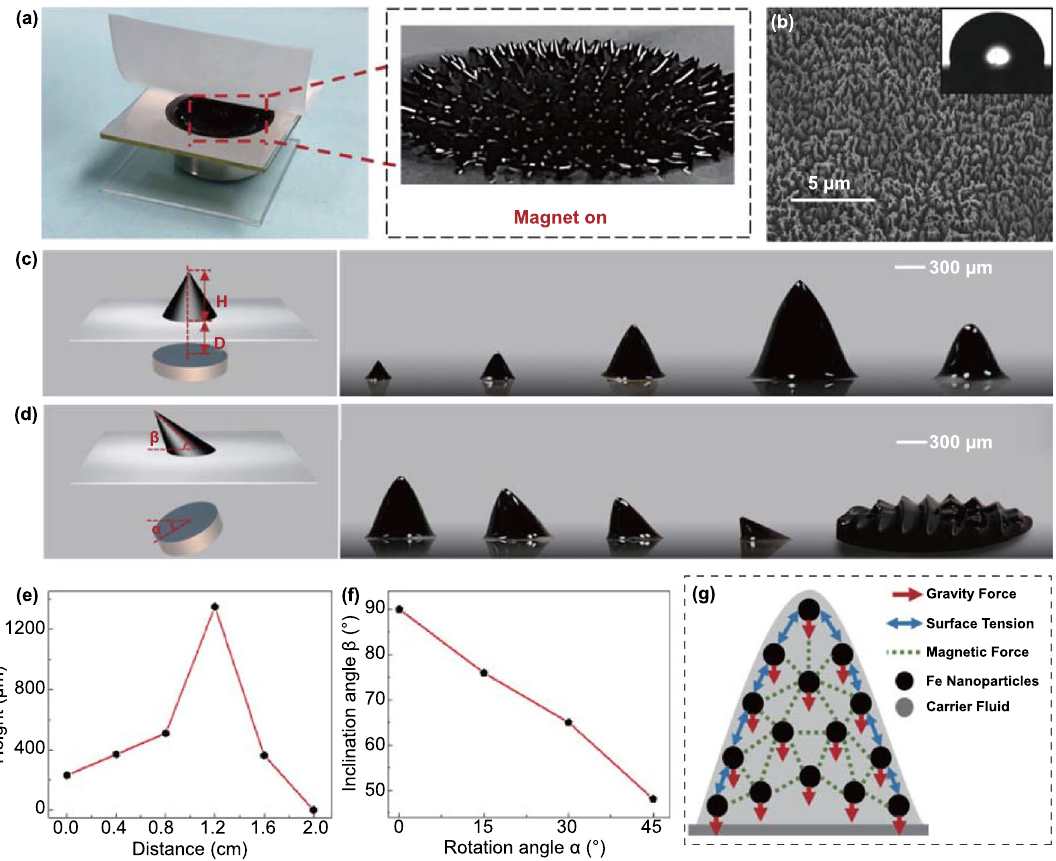
Fig. 1 Dynamic behaviors of the ferrofluid. a Photograph of FTTS. Inset displays the topography of microstructure in response to magnetic field. b The SEM image of PTFE membrane used to contact with ferrofluid, scale bar 5 μm. Inset shows the photograph of its contact angle. Schematic illustration and real-time microscope images of the dynamic behaviors of the ferrofluid in response to changing c distance and d angle with the magnet, scale bar 300 μm. Quantitative relations between different magnet conditions and geometric parameters of ferrofluid spikes: e distance and height, f rotation angle and inclination angle. g Force analysis of ferrofluid under magnetic